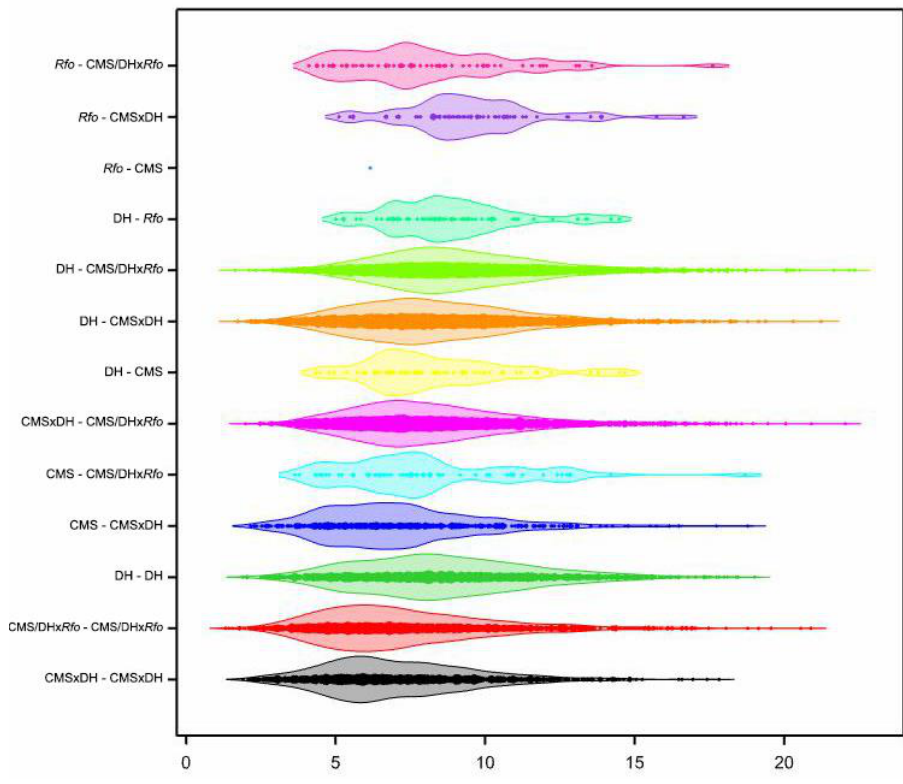
Agronomy 2021 , 11 , x FOR PEER REVIEW Figure 4. Range of Mahalanobis distances within the studied groups of genotypes in 2015.